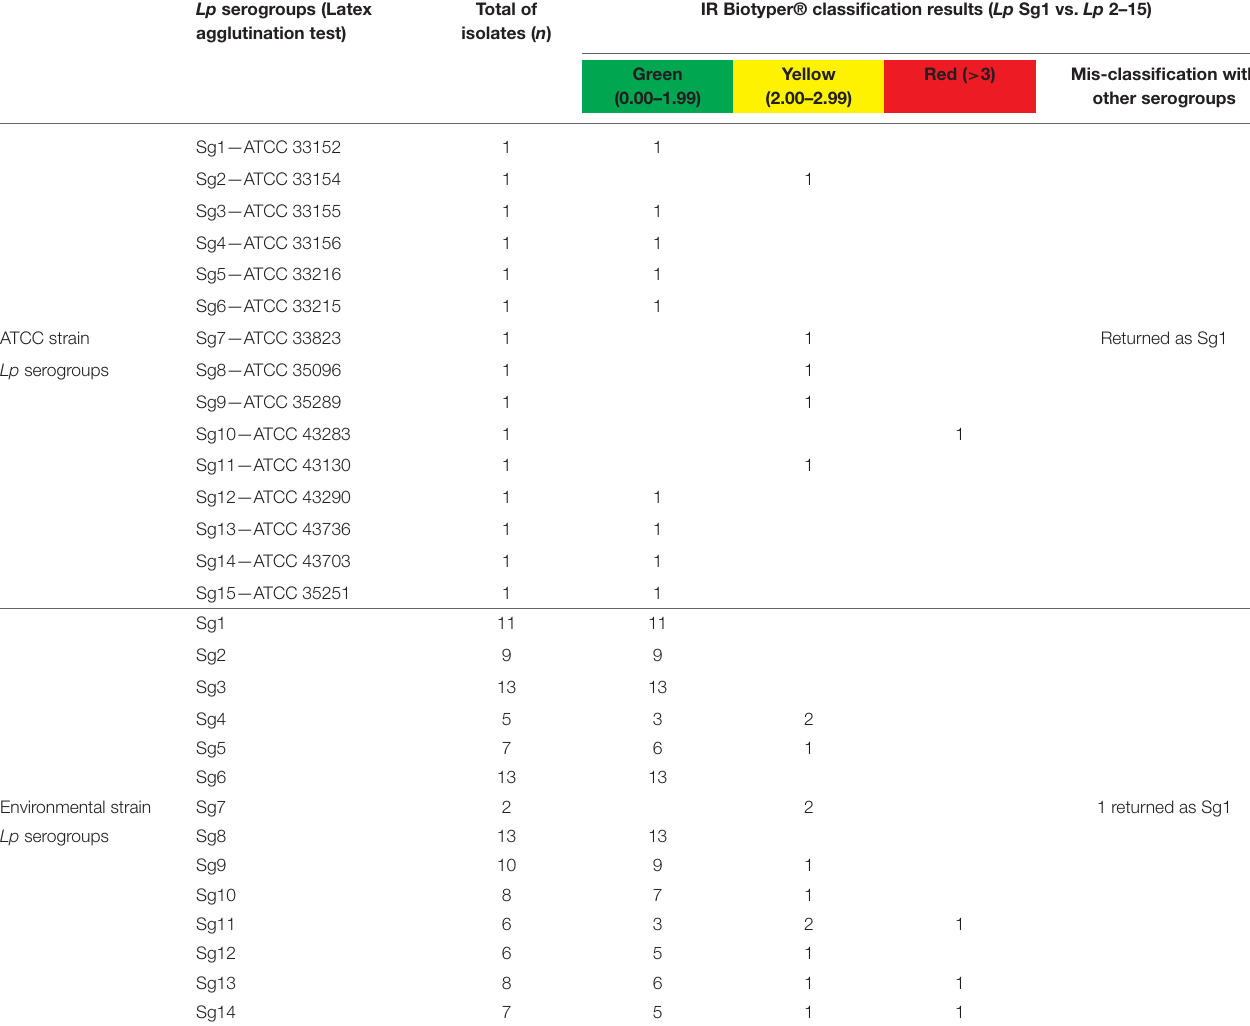
The green, yellow, and red colors represent the classification score returned by IR Biotyper® classifier.